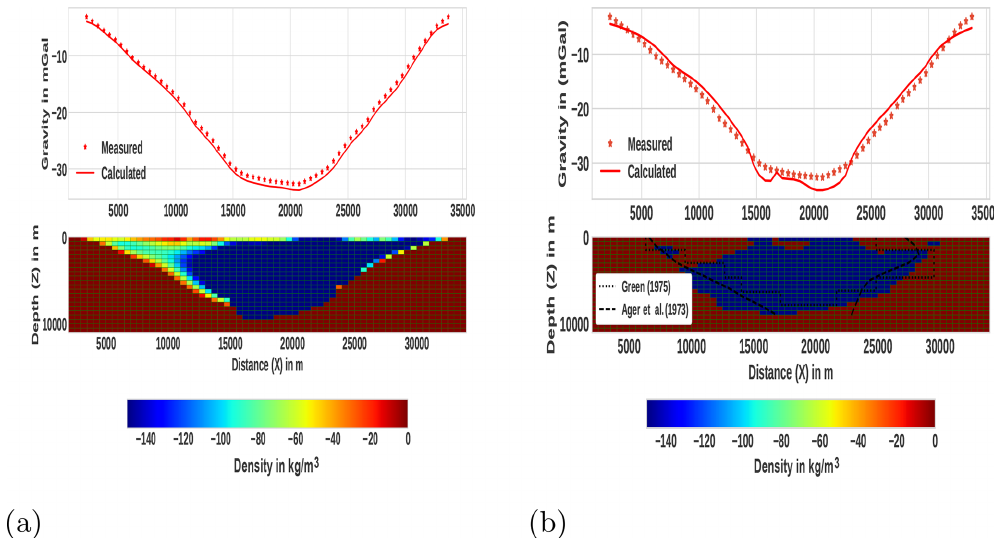
Figure 12. The observed gravity anomaly over Guichon Creek batholith in south-central British Columbia (after Green, 1975) and its inversion results. Digitized data (star marks) with calculated data (solid line) are shown on the top panels of each subfigure. The corresponding recovered density contrast models are shown on the bottom. For comparison, the results obtained by Ager et al. (1973), which were obtained from drilling, and from Green (1975) are also presented. (a) Using the conventional minimum norm ( L 2 -norm) smooth stabilizer. (b) Using the presented